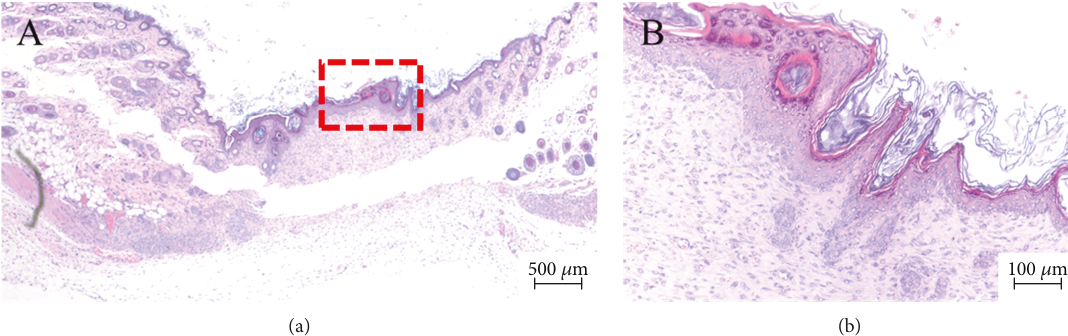
Figure 7: H&E staining (a, b) images of the full defected area of the skin treated with ProGel® captured at 4x magni fi cation and each enlarged part captured at 20x magni fi cation.